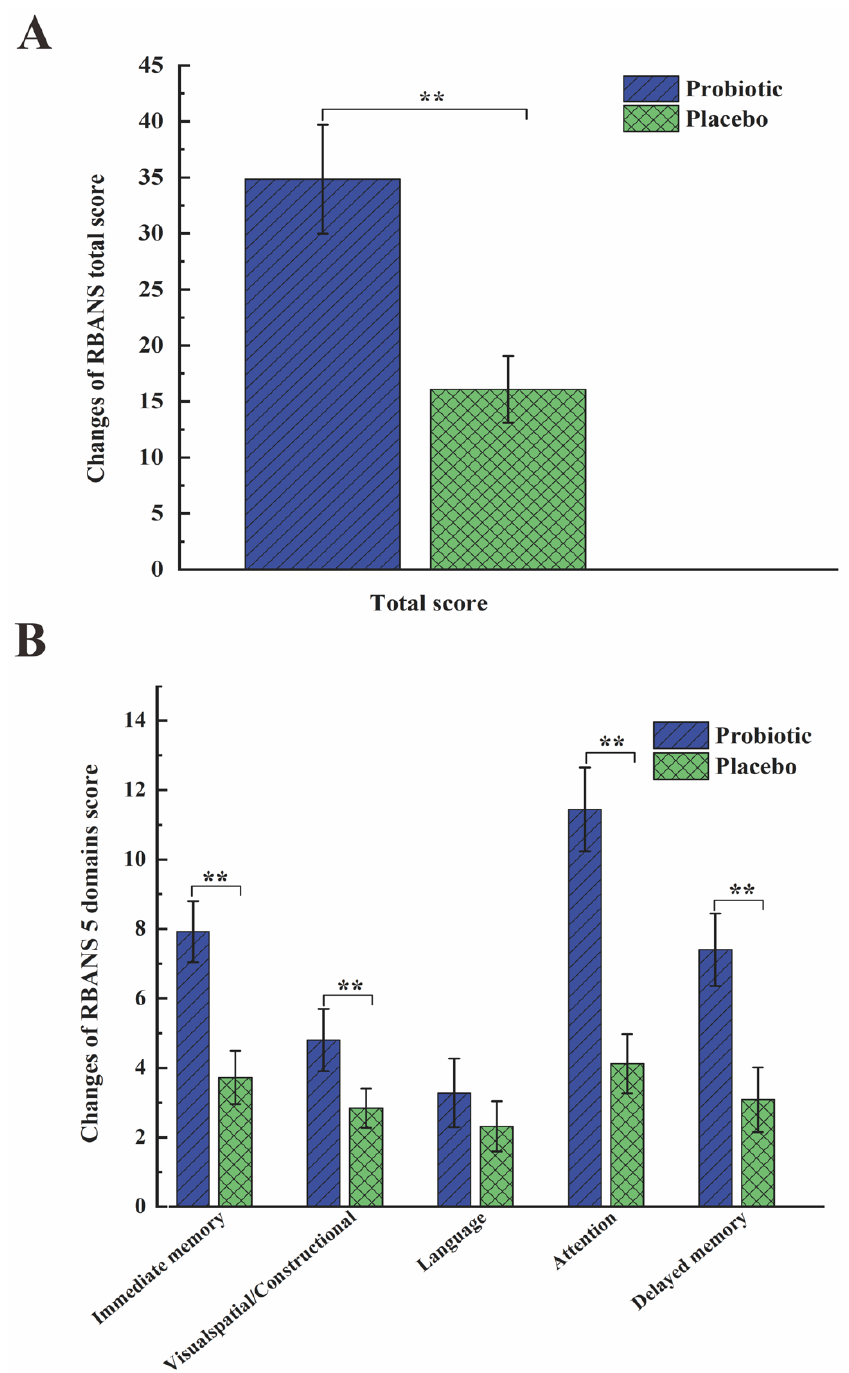
Figure 3. Changes in RBANS scores from baseline at 8 weeks. ( A ) Changes of RBANS total score from baseline at week 8. ( B ) Changes of RBANS total score from baseline at week 8. Values are indicated as mean and SE with error bars. ** p < 0.01 .